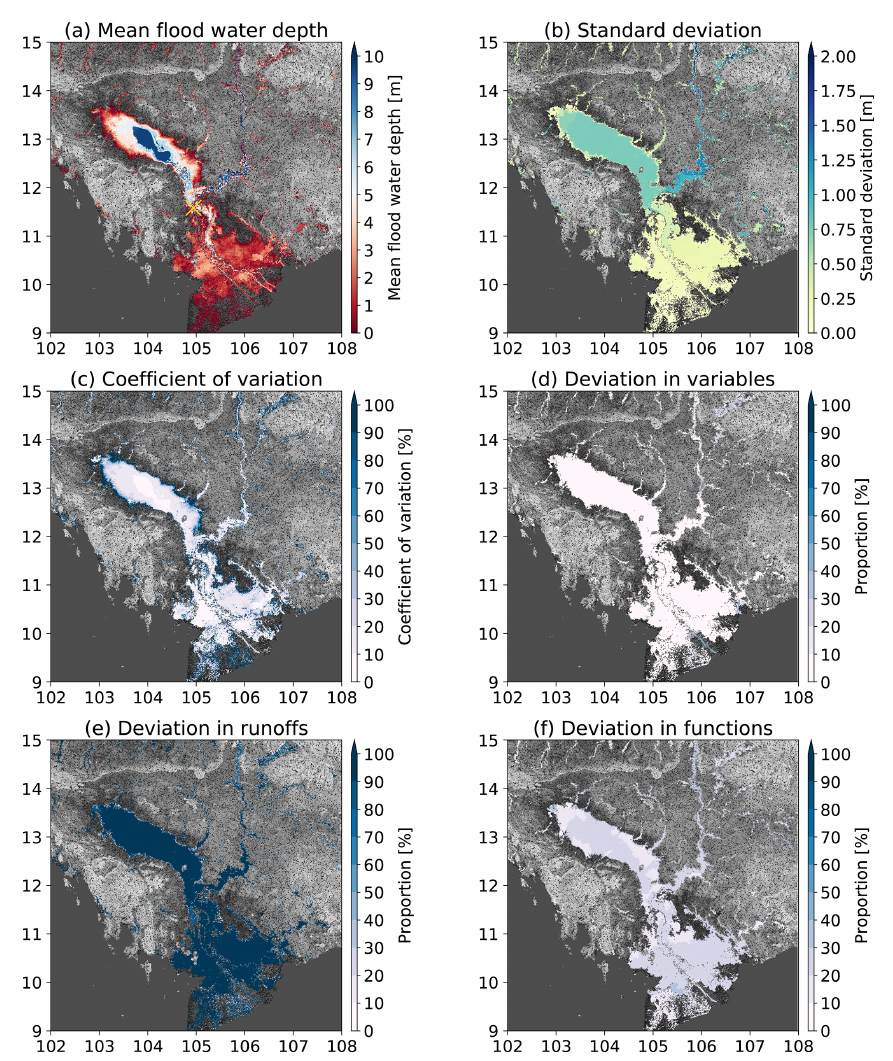
Figure 5. The mean and uncertainties of the flood water depth for the 1-in-100 year flood in the lower Mekong River basin. The mean flood- plain water depth (a) , the standard deviation (b) and the coefficient of variation (c) are estimated based on all the experiments. The deviation proportion to the overall standard deviation (b) is displayed in (d–f) for different variables, runoffs and fitting functions, respectively. The area with floodplain water depth less than 0.01m are masked out. We use multi-error-removed improved-terrain DEM (MERIT DEM) as the terrain model. The cross in yellow in (a) is the representative GRDC gauge analyzed in the next